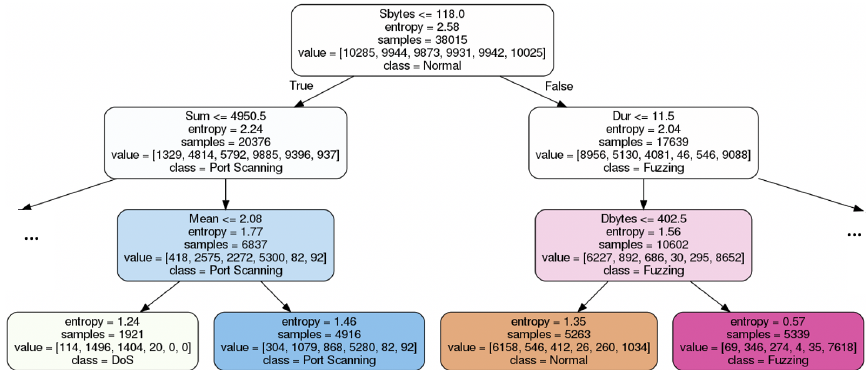
Figure 5. Sample Decision Tree from Random Forest for a Network Intrusion Detection Task.